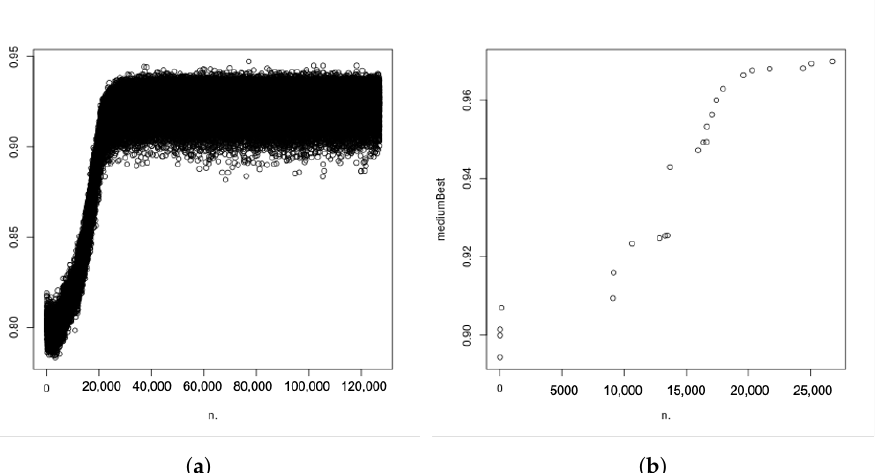
Figure 11. Time evolution of the average of the values of the utility function. ( a ) Time evolution of the average of the utility function values over one block. ( b ) Time evolution for the best iterations at each